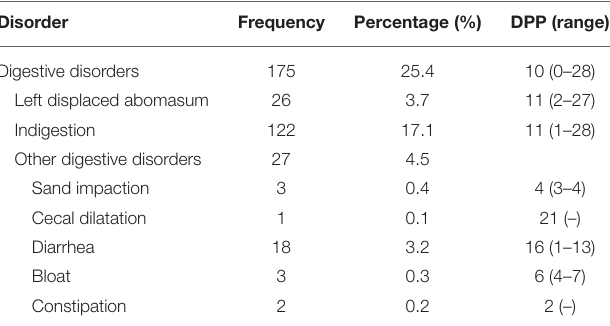
Milk Yield and Energy-Corrected